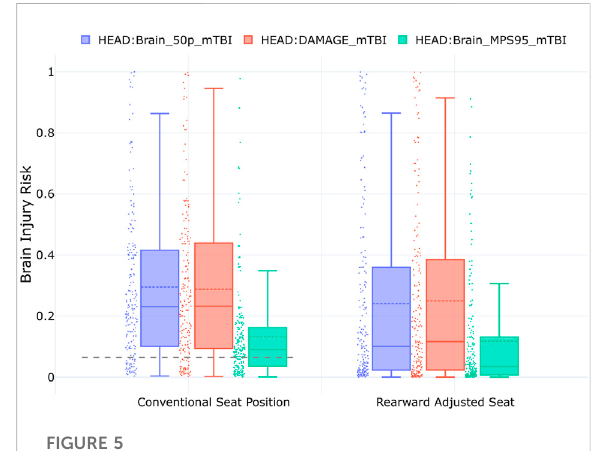
FIGURE 5 Boxplots for risk of mTBI based on three different brain IRFs. The three boxplots on the left show the results of the simulations with the conventional ( n = 185), and the three on the right the results with therearward adjusted seat position ( n = 185). The gray dashed line represents the head injury risk observed in the IGLAD